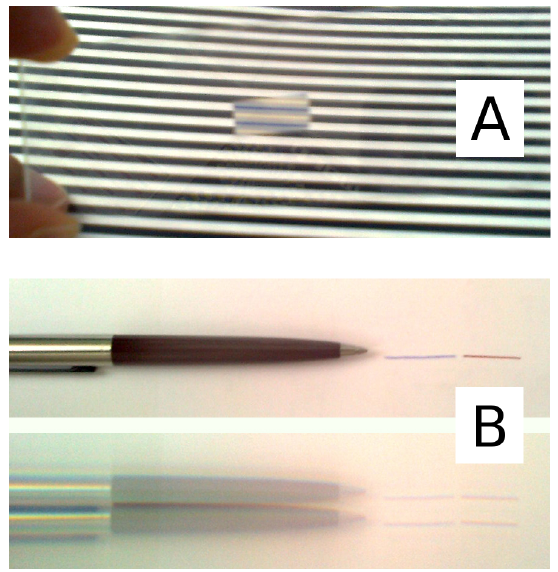
Figure 2. Image through one of the gratings fabricated of: A) a black and white object and B) a long